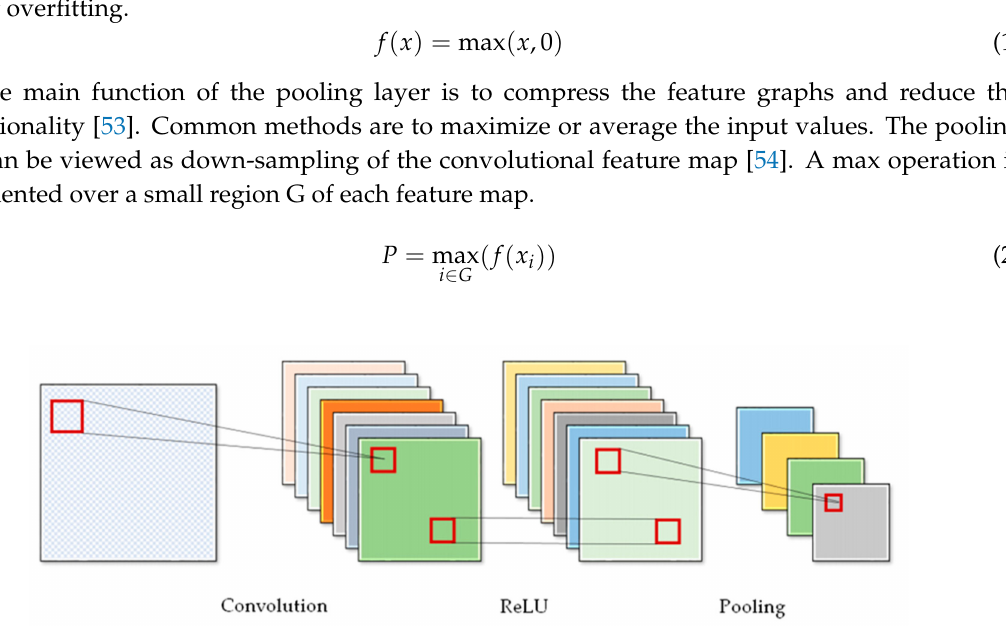
Figure 4. Illustration of typical layers of a CNN